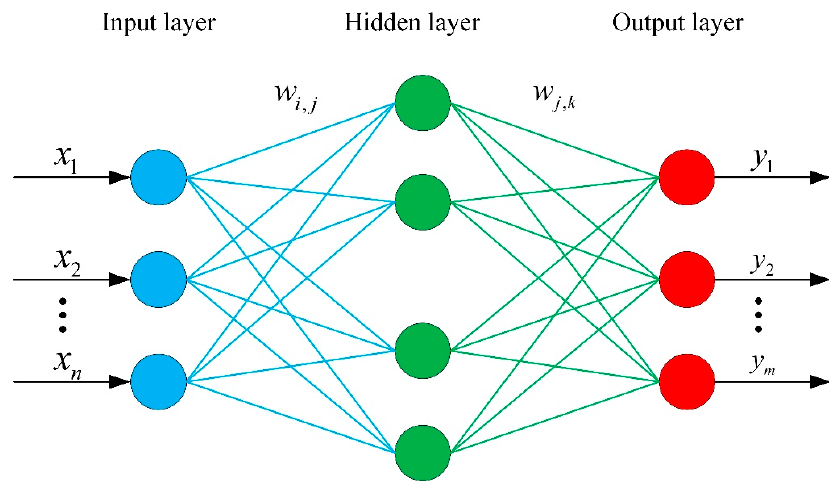
Figure 18. BP neural-network framework.